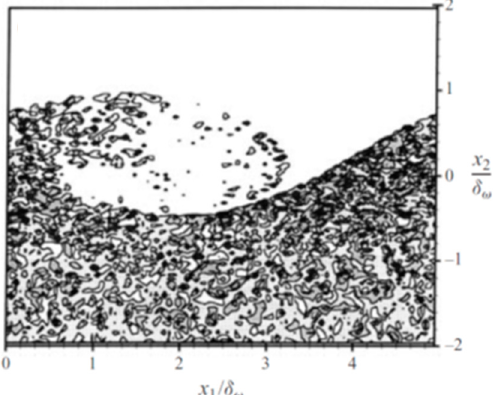
Figure 3. Instantaneous contour plot of the droplet number density on the spanwise plane x 3 = 0 at non-dimensional time t = 50 with mass loading ratio 0.225 [12]. The mainstream gas flows in the x 1 direction. The droplet distribution is strongly affected by the gas-phase vortex roll-up. Reproduced with permission from Cambridge University Press.